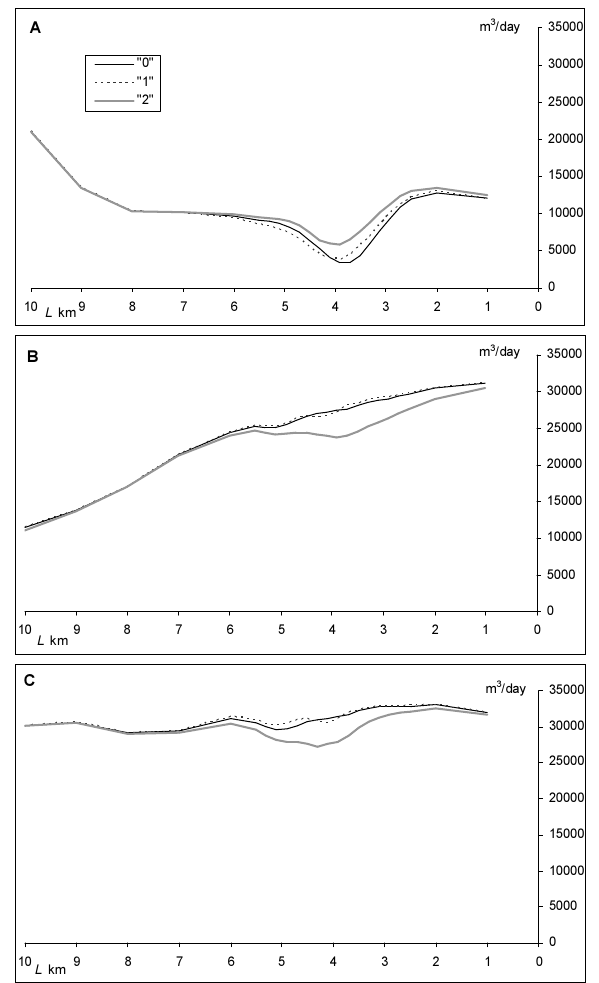
th st cross section (1 km to